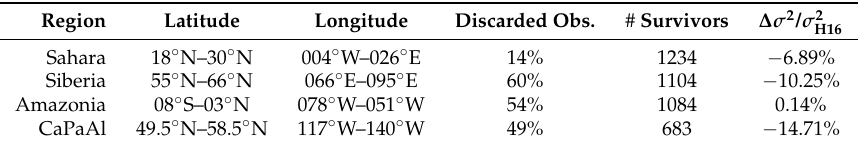
Table 4. The examined regions along with their spatial extent, rate of filtered observations and number of measurements after postprocessing in April 2004. The relative change in the norm of the spectral fitting residual is given in the last column.